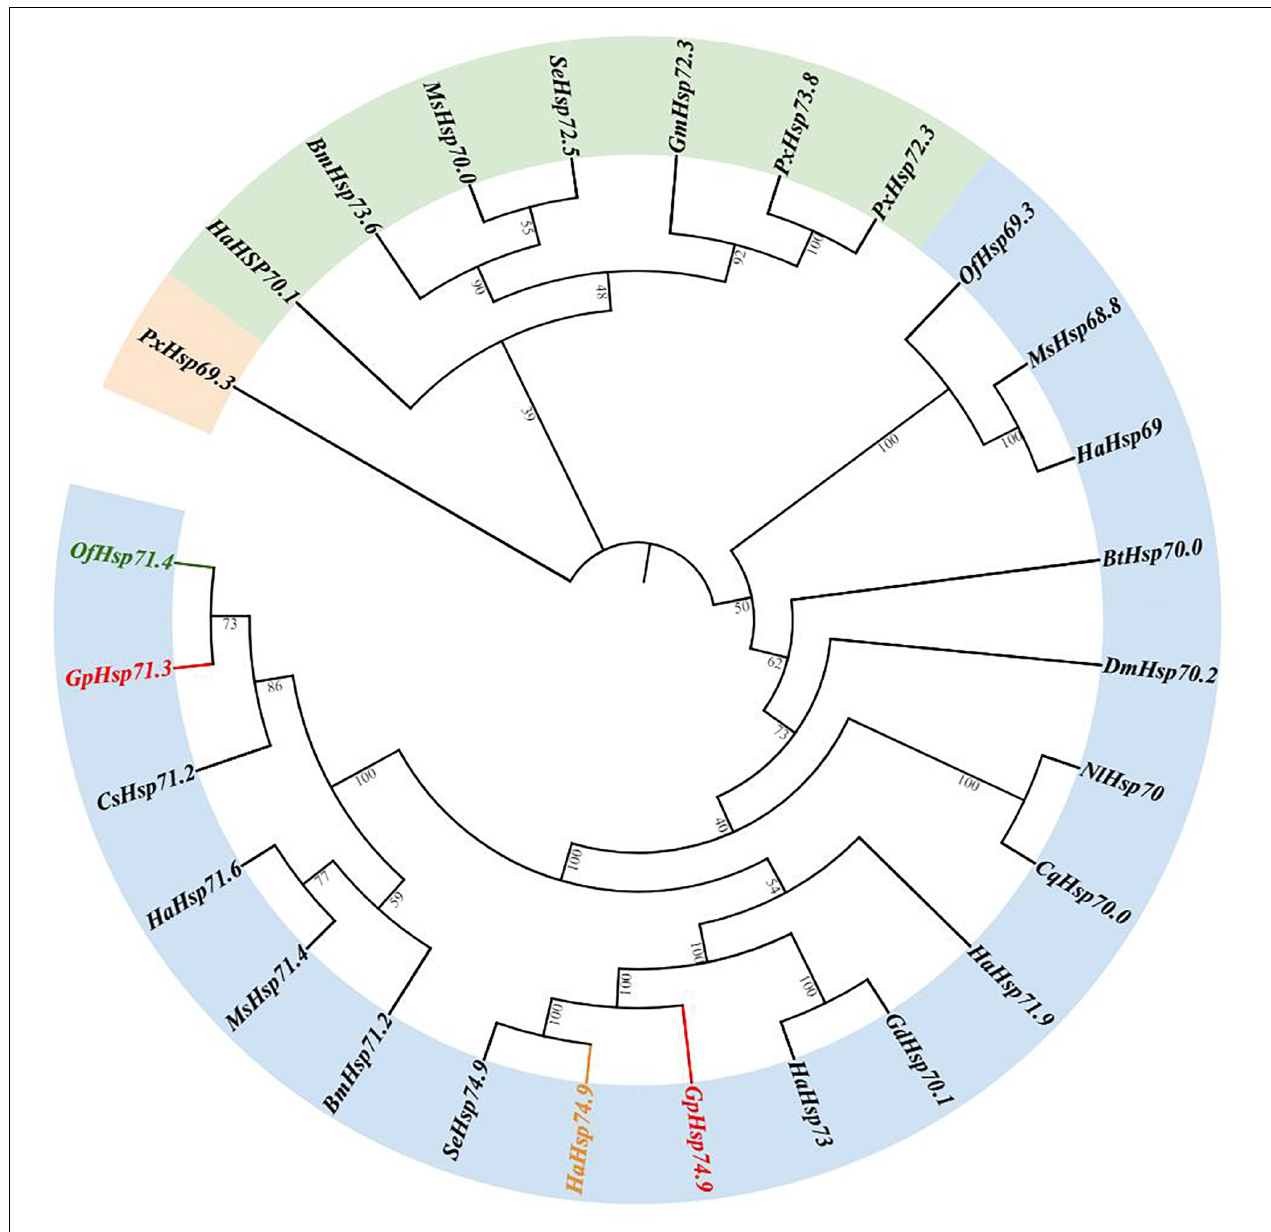
FIGURE 3 | The neighbor-joining tree of GpHsp70s deduced from the coding sequence (CDS) between G. pyloalis and other insect species. GpHsp71.3 and GpHsp74.9 in red, OfHsp71.4 in green, and HaHsp74.9 in orange. Bombyx mori (Bm), Helicoverpa armigera (Ha), Manduca sexta (Ms), Ostrinia furnacalis (Of), Plutella xylostella (Px), Spodoptera exigua (Se), Bemisia tabaci (Bt), Nilaparvata lugens (Nl), Harmonia axyridis (Ha), Galeruca daurica (Gd), Drosophila melanogaster (Dm), Culex quinquefasciatus (Cq), Chilo suppressalis (Cs), Grapholita molesta (Gm).